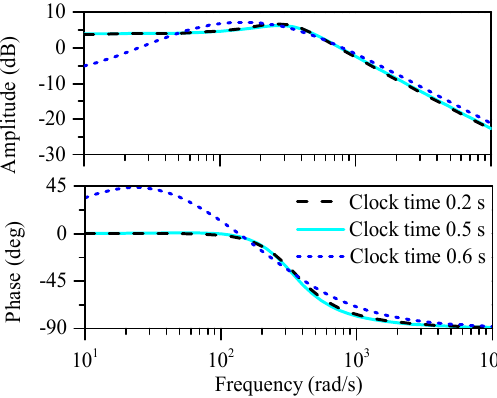
Figure 9. Bode plot of the identified motor under different clock times.